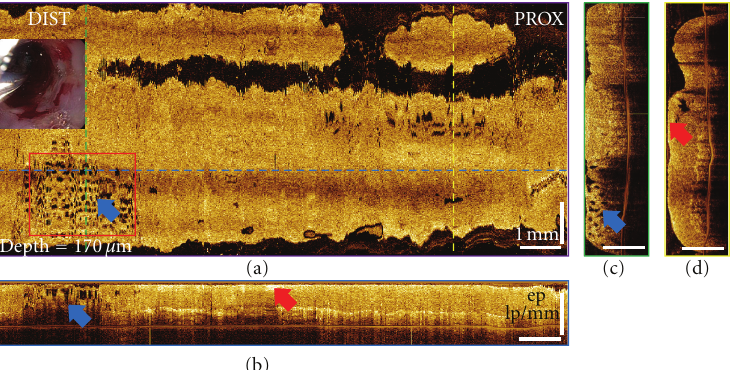
Figure 5: 3D-OCT orthoplanes from the BE region immediately after CSA treatment. (a) The en face orthoplane is located at a depth of 170 µ m. The colored dotted lines indicate location of complementary orthoplanes (b), (c), and (d). Blue arrows indicate the locations of the edema-like tissues, and red arrows indicate the hyperscattering necrotic tissues on top of the treated regions. (b) The cross-sectional YZ orthoplane shows the epithelium (ep), lamina propria (lp), and muscularis mucosa (mm). (c) The cross-sectional XZ orthoplane shows the edema-like tissue extending into the muscularis mucosal layer. (d) The cross-sectional XZ orthoplane shows the hyperscattering, detached tissue on top of the treated area. Inset shows a video endoscopy image with the 3D-OCT probe in position prior to image acquisition. Red box indicates region of interest in Figure 6.